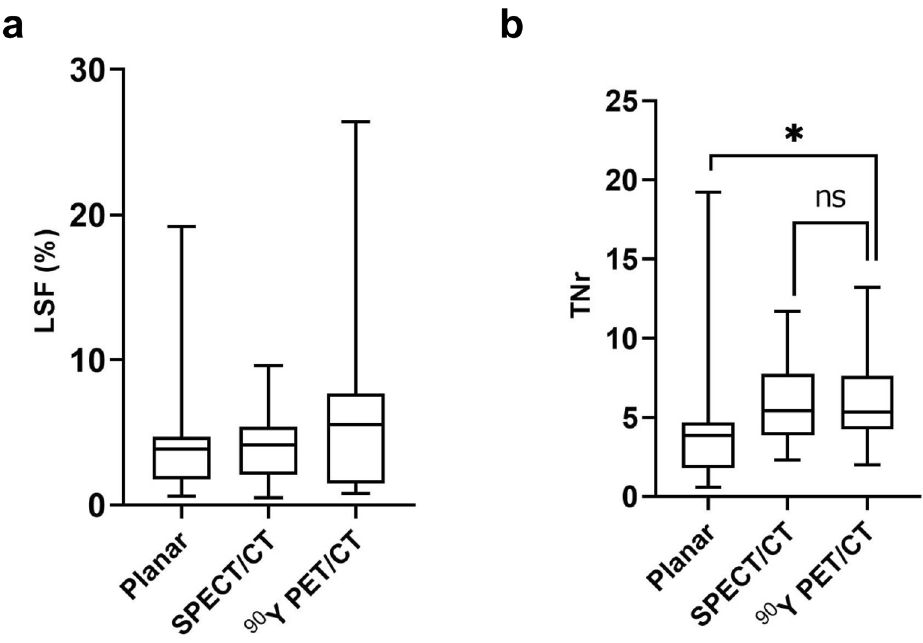
Figure 1. Comparison of %LSF ( a ) and TNr ( b ) between Planar, SPECT/CT and